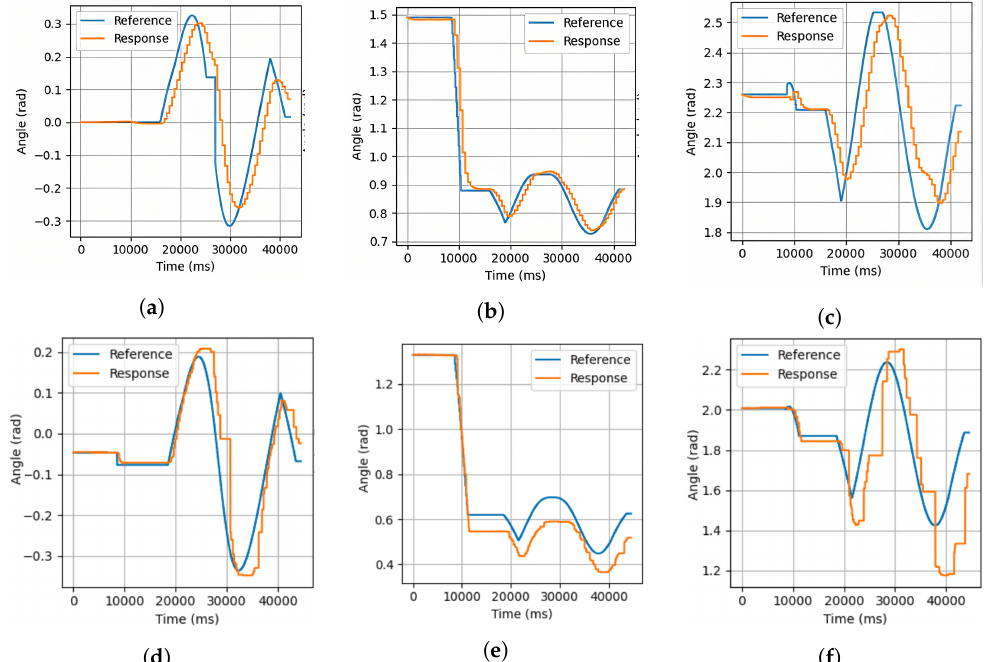
Figure 9. Digital twin ( a – c ) and real joints trajectories ( d – f ) of a single module while performing a circular movement (trajectory shown on Figure 8). ( a ) Joint 1 of the digital twin, ( b ) Joint 2 of the digital twin, ( c ) Joint 3 of the digital twin, ( d ) Joint 1 of the physical organism, ( e ) Joint 2 of the physical organism, and ( f ) Joint 3 of the physical organism.